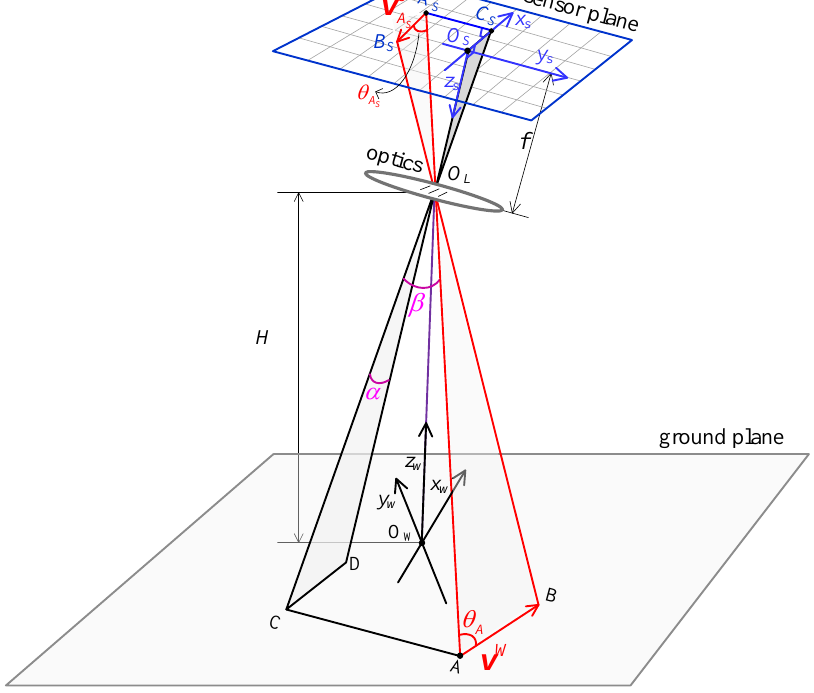
Figure 5. Schematic diagram of airborne area camera photography.